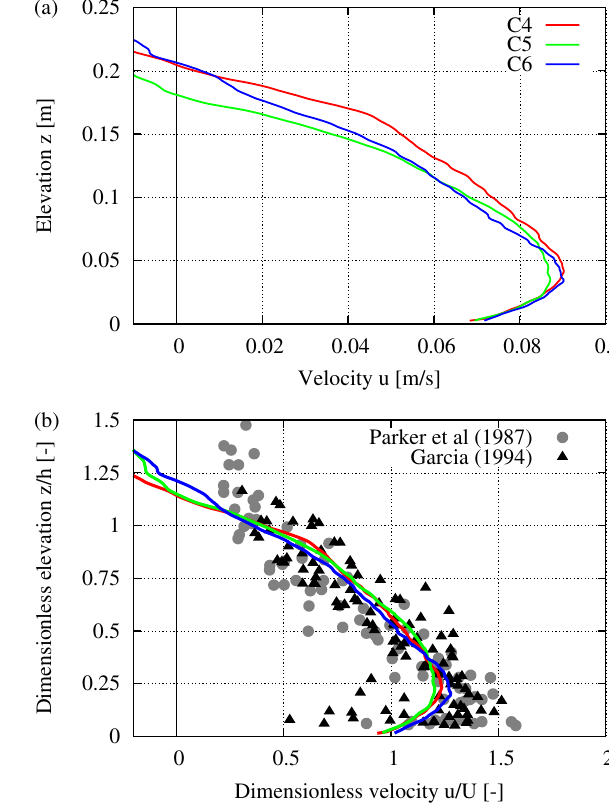
Figure 5. Velocity profiles measured in experiment S4 (saline flow, q 0 = 0 . 0034m 2 s − 1 , ∆ ρ/ρ = 0 . 6%). (a) Spatial distribution of longi- tudinal velocity and flow interface (blue line) measured during the experiment. The interface height obtained from the corresponding velocity profile (blue dots) employing Eqs. (1) and (2) is also reported. (b) Dimensionless velocity profiles.